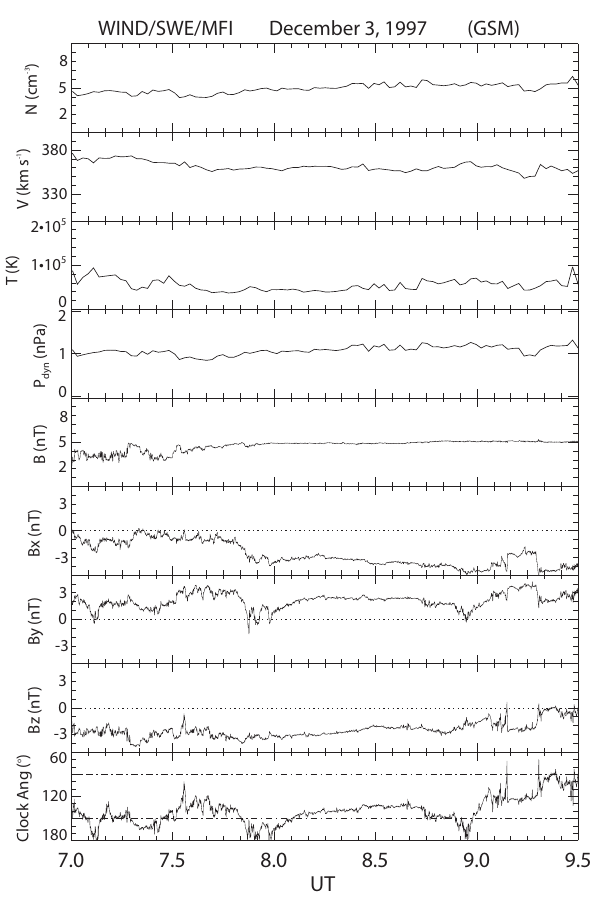
Fig. 2. Wind magnetic field and solar wind plasma data for the interval 07:00–09:30UT. Panels from top to bottom shows proton density, bulk speed, temperature, dynamic pressure, the total mag- netic field and its components B x , B y , and B z . The bottom panel shows the IMF clock angle in the GSM Y-Z